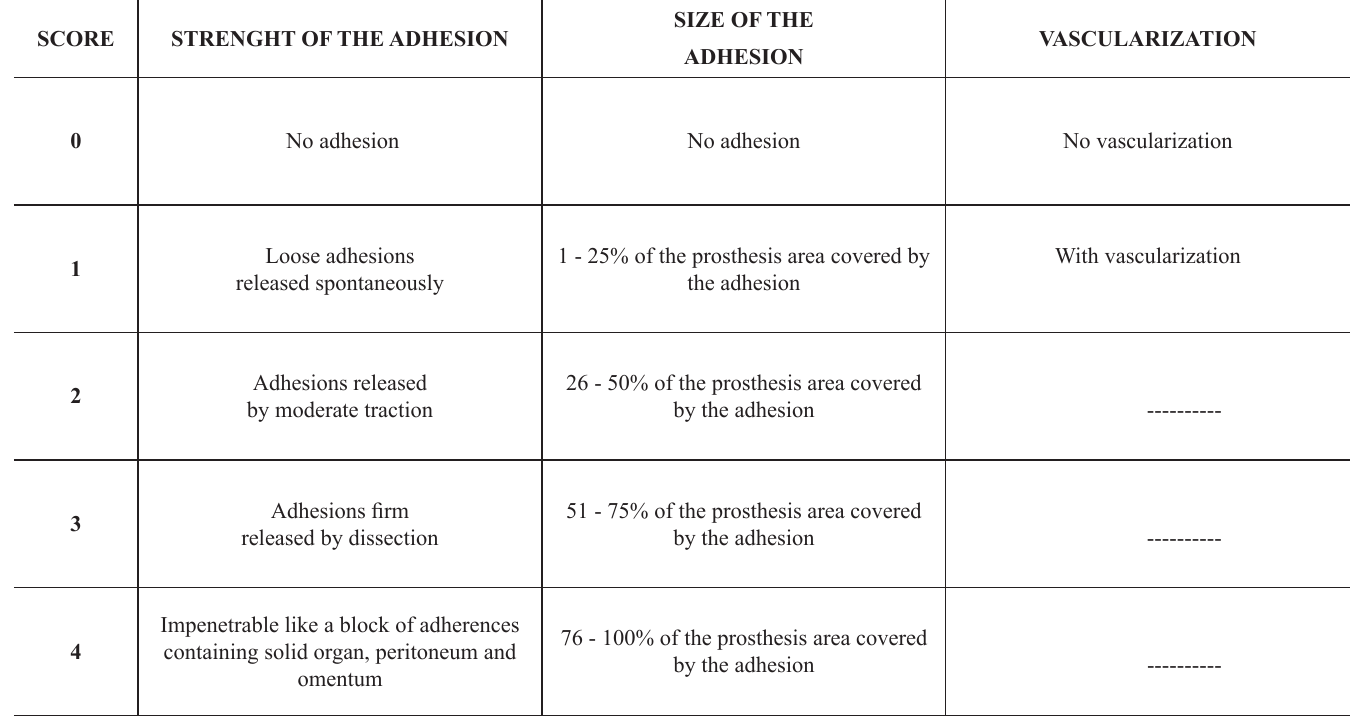
TABLE 1 - Semi-quantitative scoring system of adhesion and